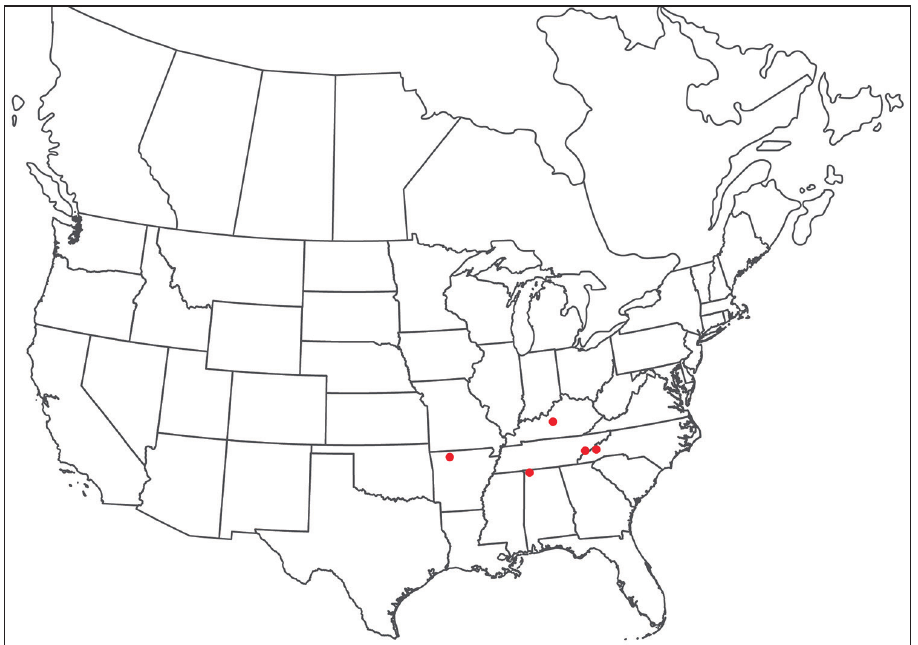
Figure 78. Torrenticola flangipalpa sp. n.